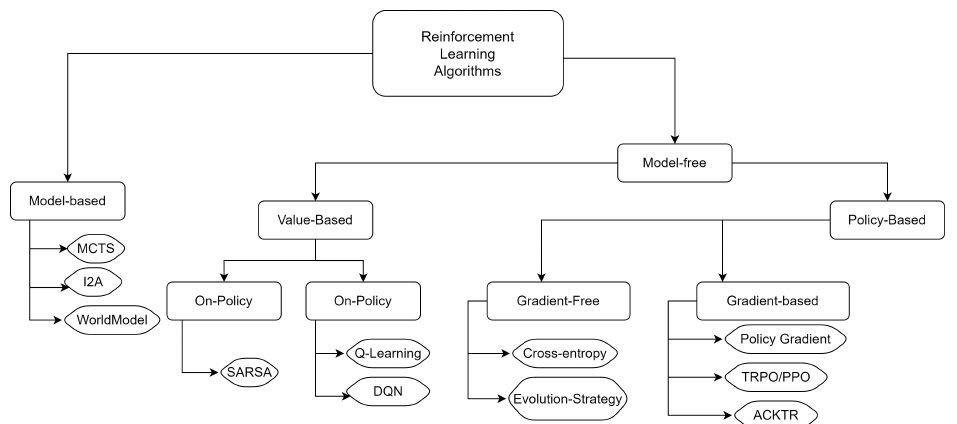
Figure 5. Taxonomy of popular RL